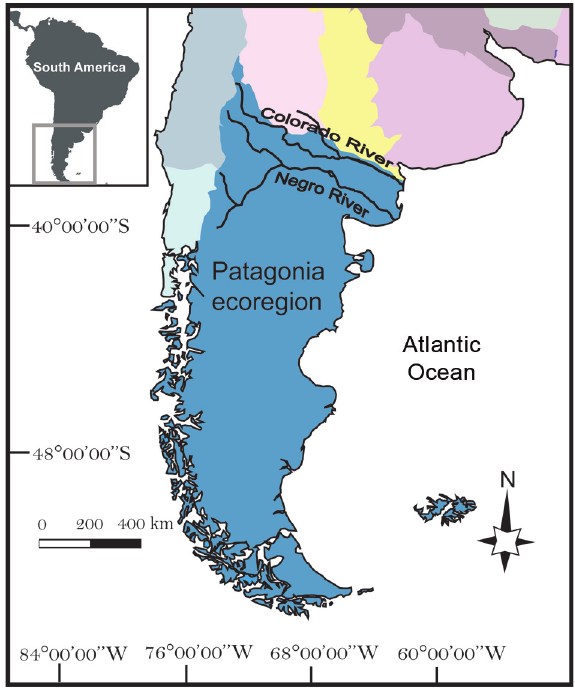
Figure 1. Location of the Negro river drainage within the Patago- nia ecoregion. Modified from Abell et al.